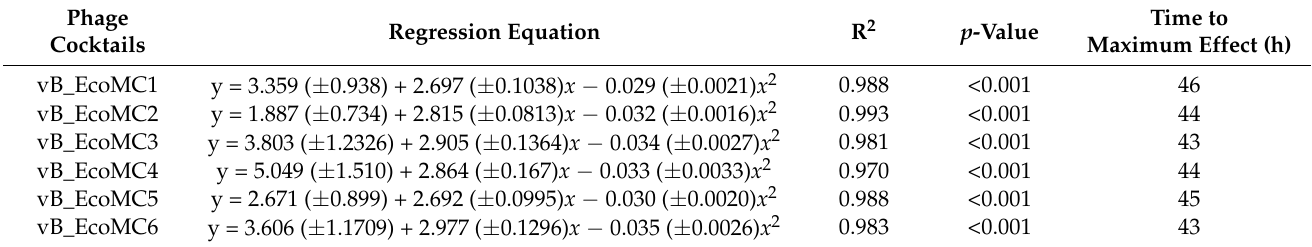
Table 6. Relationship between in vitro ruminal incubation time ( x ) and percent reduction in E. coli O177 cells ( y ) when challenged with phage